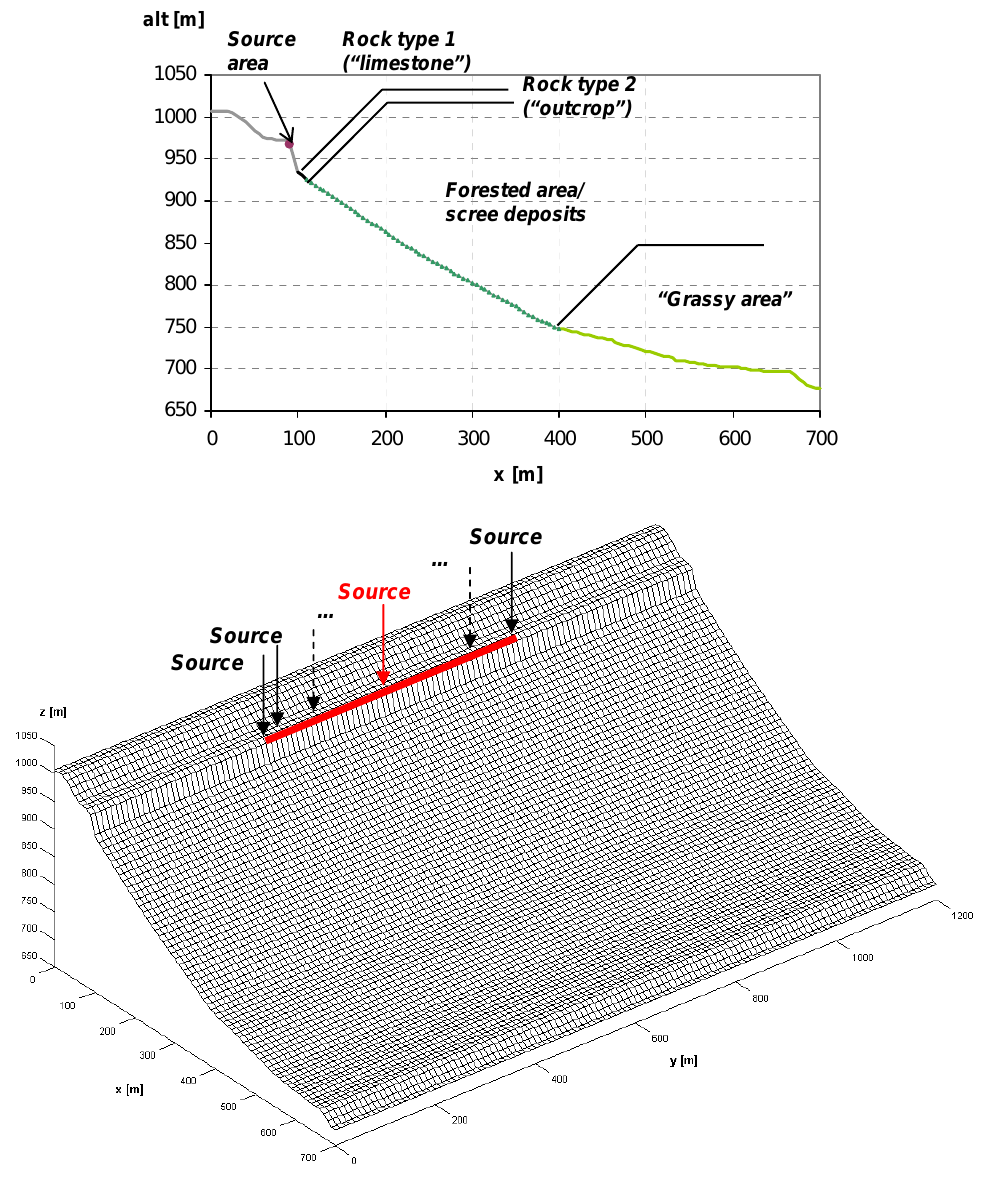
Figure 4. Linear cli ff model obtained from a 2D slope profile. The red line indicates the linear rock fall source area corresponding to the red point in the top